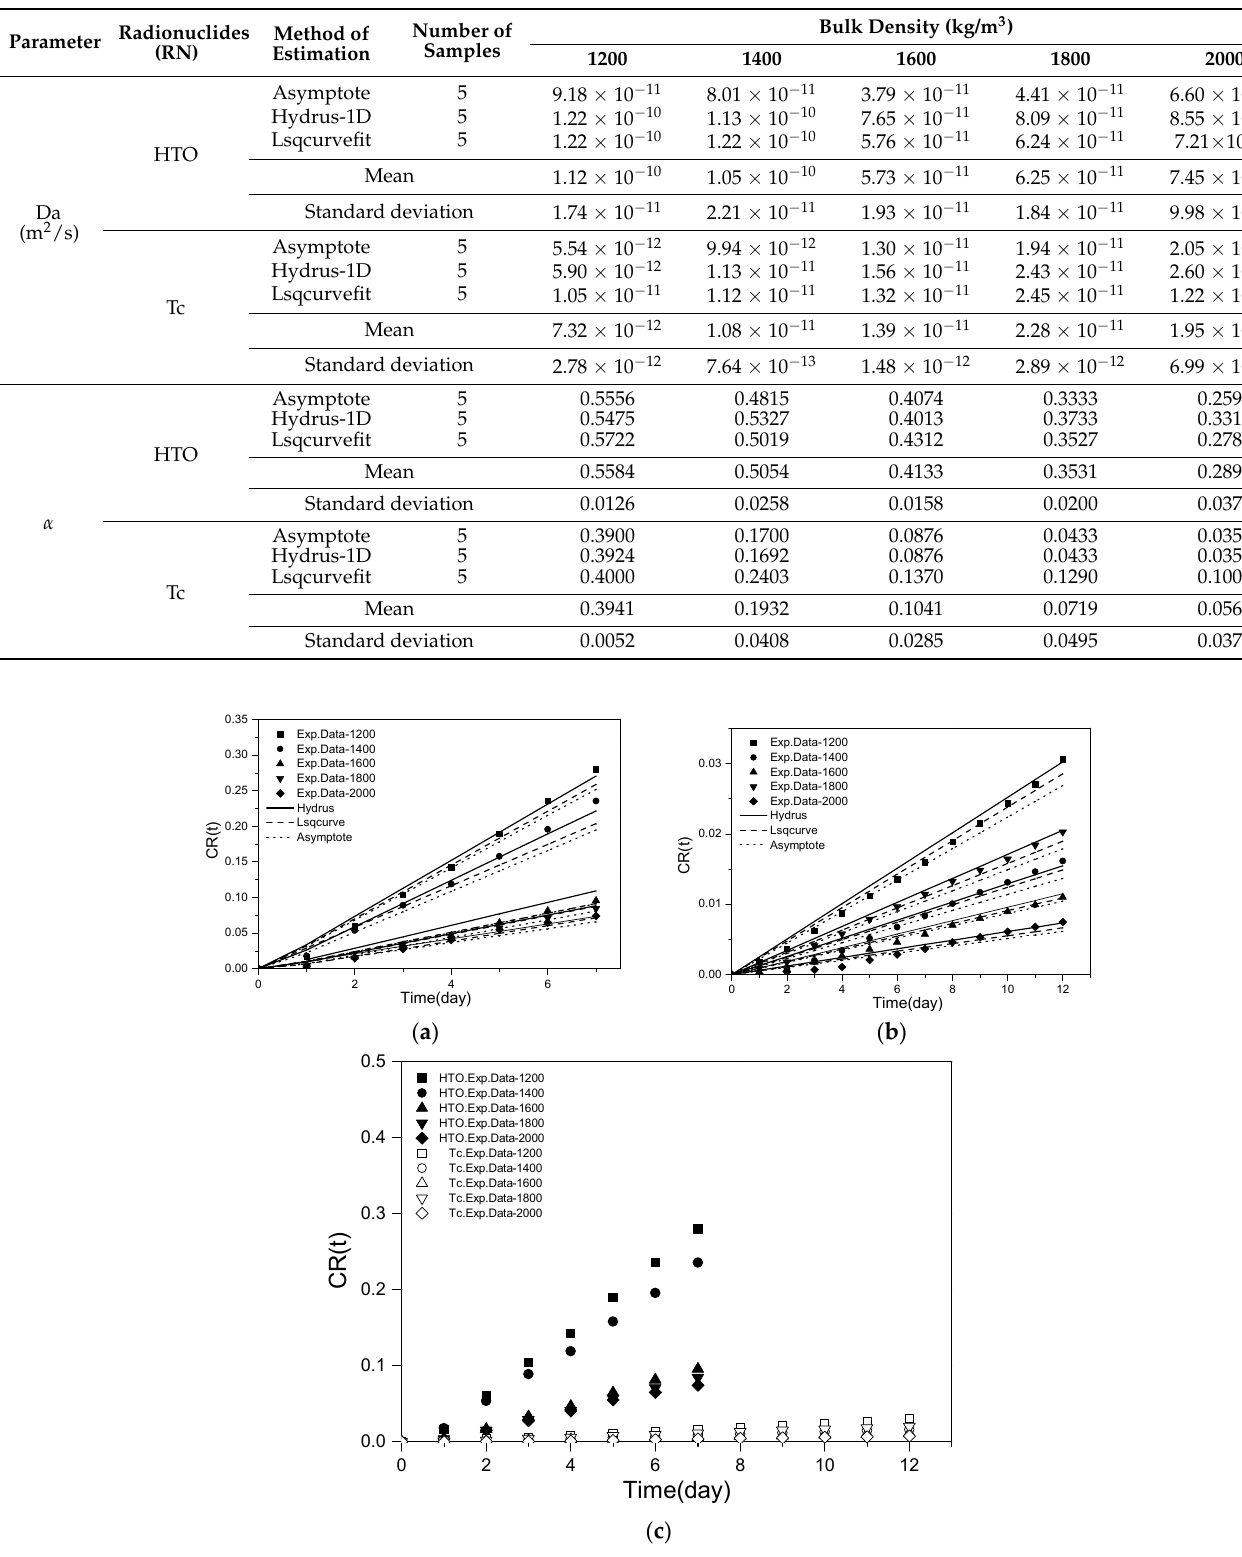
Table 1. The through-diffusion conditions for the HTO and Tc in compacted MX-80 bentonite.